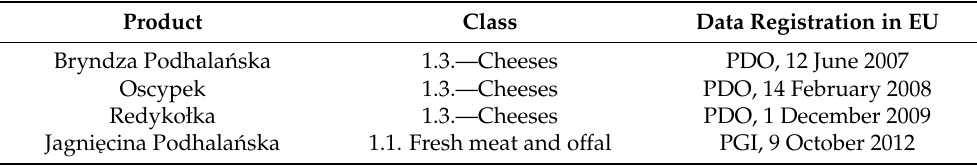
Table 2. Traditional and regional products from Polish mountain sheep. Product Class Data Registration in